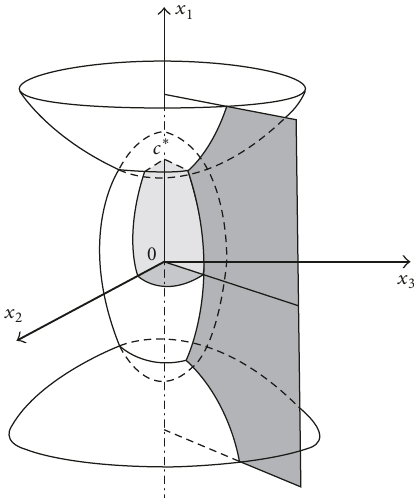
Figure 1: The prolate spheroidal geometry and the three coordinate surfaces, that is, prolate spheroids ( 𝜏 = const.), hyperboloids of two sheets ( 𝜁 = const.), and meridian planes ( 𝜑 = const.) with 𝑐 being the semifocal distance of the coordinate